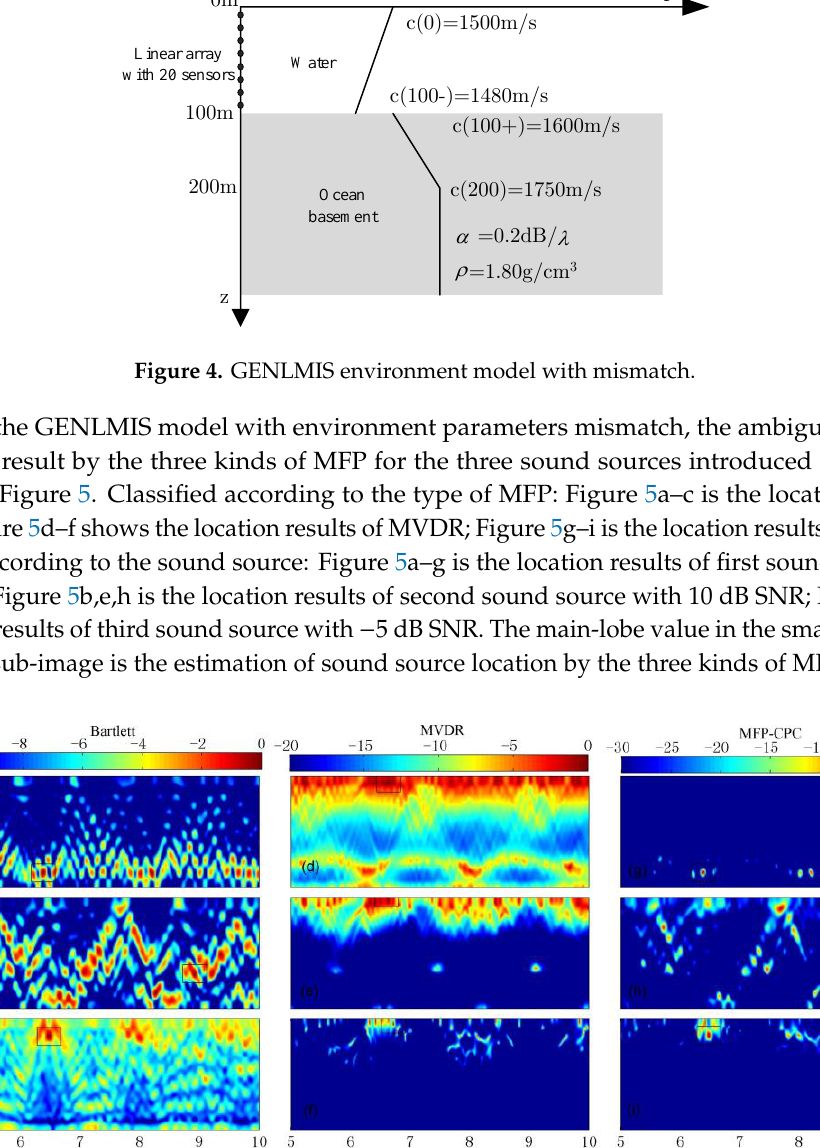
Figure 5. Localization results for the three MFP methods under GENLMIS environment model.